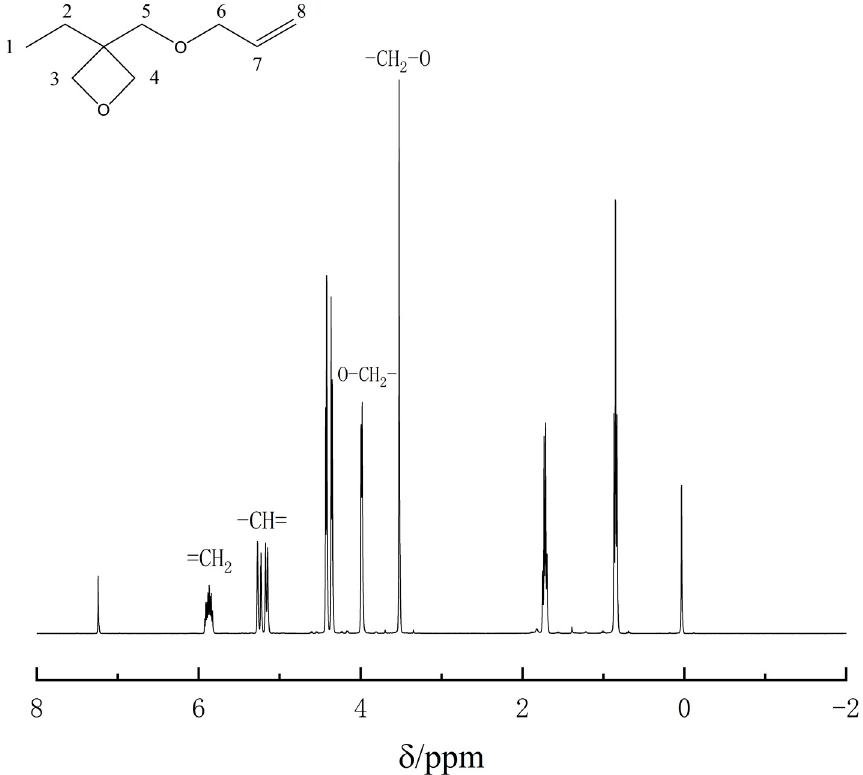
Figure 6. The hydrogen spectrum of 3-ethyl-3-allylmethoxyoxetane. Table 2. Analytical table of the 1 H-NMR spectrum for the 3-ethyl-3-allylmethoxyoxetane. Location of H